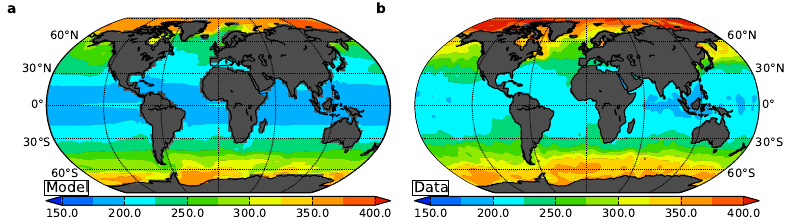
Figure 11. Oxygen distribution at the ocean surface (µmolkg − 1 ). Data from the World Ocean Atlas 2009 (Garcia et al., 2010a).